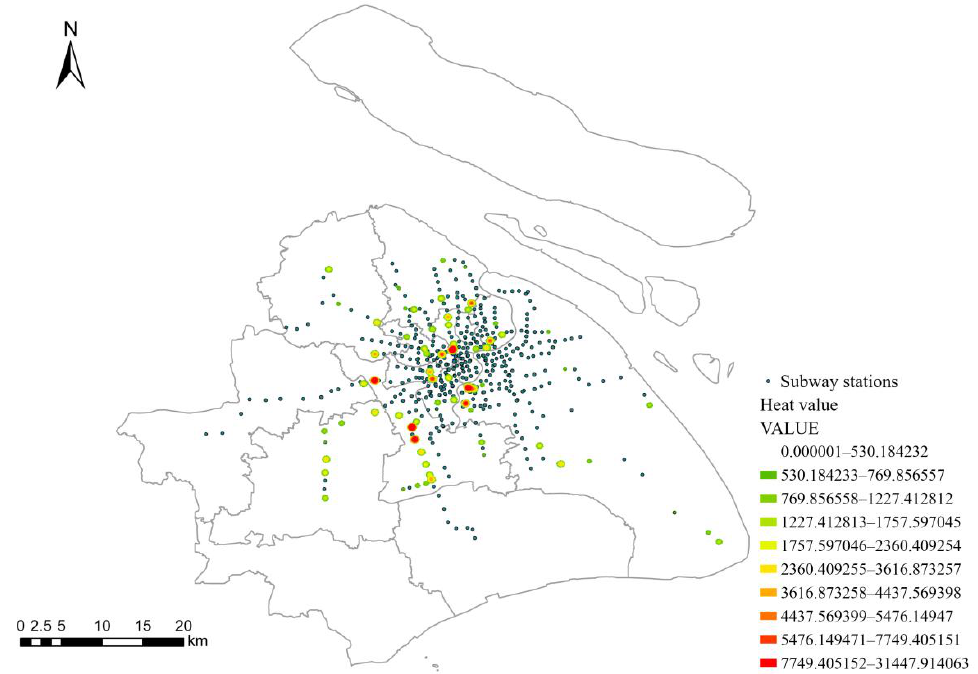
Figure 6. Heat map of passenger flow distribution of rail transit stations in Shanghai.